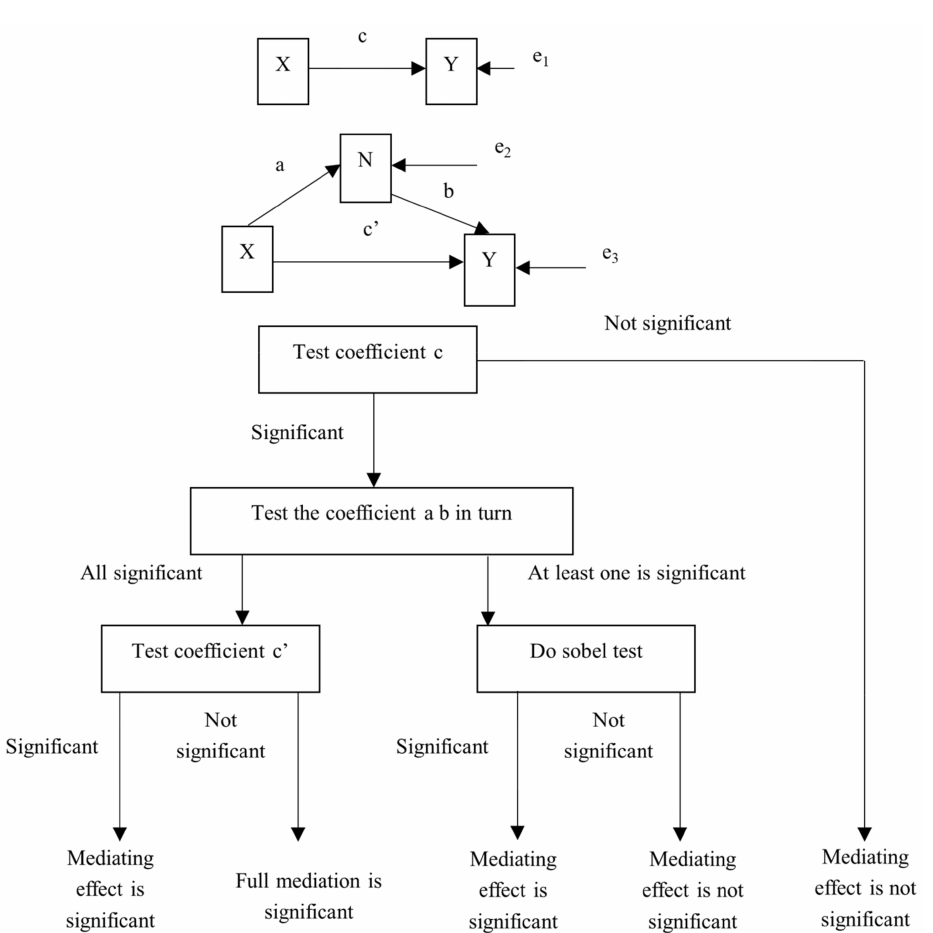
Figure 2. Mediating effect test